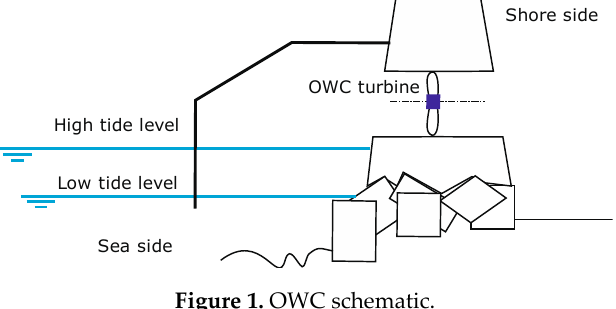
Figure 1. OWC schematic.